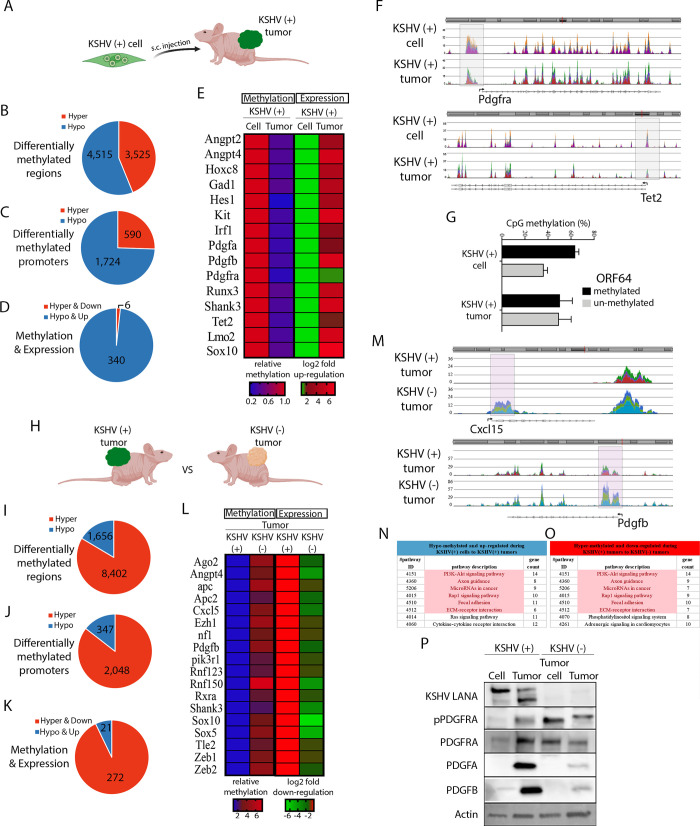
Methylation footprint of KSHV infection in the context of KSHV oncogenesis.(A) Scheme of the comparison between KSHV (+) cell and KSHV (+) tumor. (B) The number of differentially methylated regions. Red represents hyper-methylation, and blue represents hypo-methylation. (C) Differentially methylated promoters (-1500 to +200 relative to TSS). Red represents hyper-methylation, and blue represents hypo-methylation. (D) Differentially methylated promoters that were correlated with gene expression. Red represents hyper-methylation, and blue represents hypo-methylation. (E) Heat map of selected genes with differentially methylated promoters that were correlated with gene expression in the RNA-sequencing analysis. (F) Chromosome view of gene promoters which were differentially hypo-methylated. (G) Evaluation of KSHV methylation was performed on MBD2-beads enriched DNA followed by qPCR of the methylated region in ORF64. Percentage of un-methylated (gray) and methylated (black) fractions are presented. (H) Scheme of the comparison between KSHV (+) tumors and KSHV (-) tumors. (I) The number of differentially methylated regions. Red represents hyper-methylation, and blue represents hypo-methylation. (J) Differentially methylated promoters (-1500 to +200 relative to TSS). Red represents hyper-methylation, and blue represents hypo-methylation. (K) Differentially methylated promoters that were correlated with gene expression. Red represents hyper-methylation, and blue represents hypo-methylation. (L) Heat map of selected genes with differentially methylated promoters that were correlated with gene expression in the RNA-sequencing analysis. (M) Chromosome view of gene promoters which were differentially hypo-methylated. (N) Gene ontology analysis on STRING identified pathways that were induced during KSHV-dependent tumorigenesis. Common pathways that were repressed following viral loss are marked in pink. (O) Gene ontology analysis on STRING identified pathways that were repressed during tumorigenesis following KSHV-episome loss. Common pathways that were induced following tumorigenesis with the virus are marked in pink. (P) KSHV-LANA, total and phospho-PDGFRA together with PDGFA and PDGFB levels were analyzed by immunoblotting in KSHV (+) cells, KSHV (+) tumors, KSHV (-) tumor cells and KSHV (-) tumors. Actin was used as loading control.